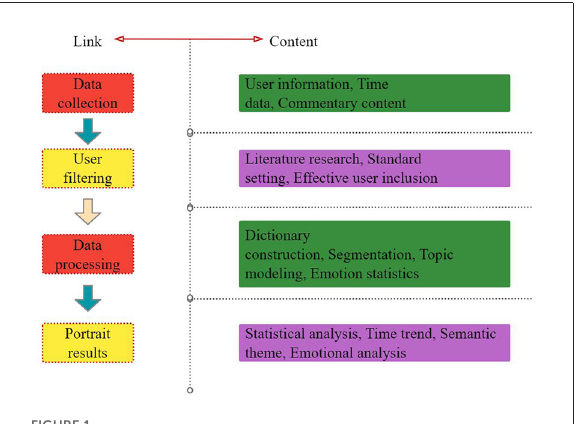
FIGURE1 Construction process of portrait of depressed